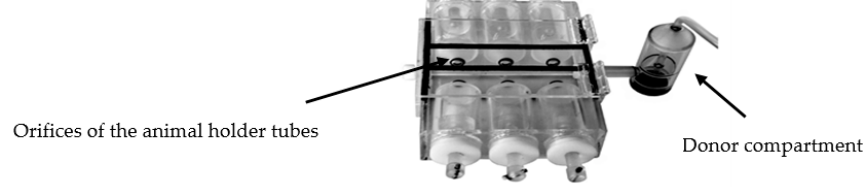
Figure 1. Photograph of the inhalation chamber [19].